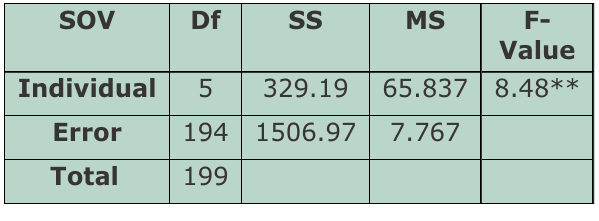
Figure-II: Effect of breakfast skipping on BMI. Table-III: Analysis of Variance (ANOVA) for Body Mass Index